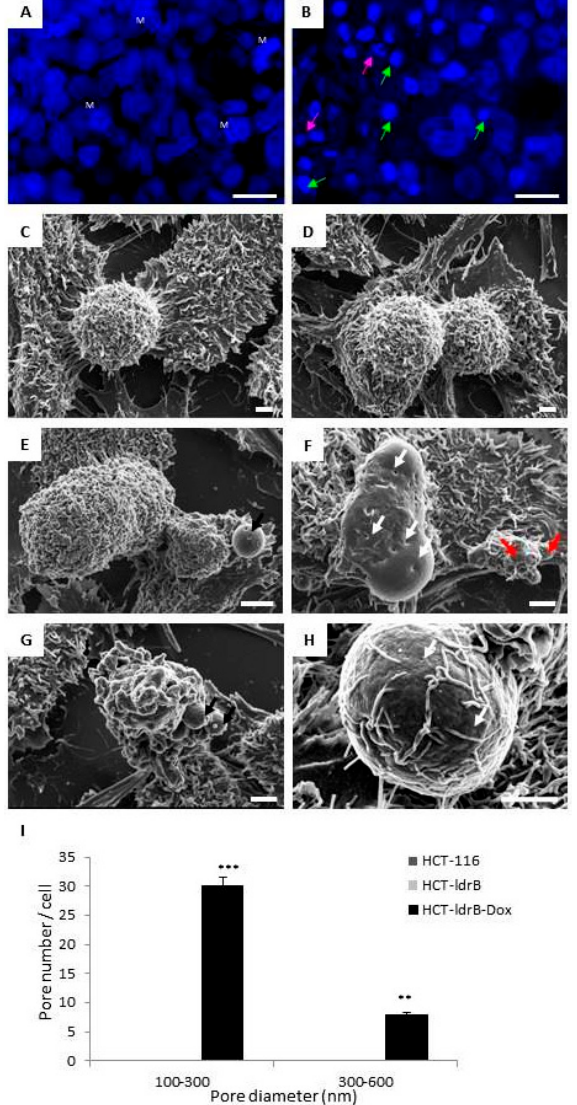
Figure 4. Expression of the ldrB gene induces apoptosis and pore formation in HCT-ldrB-dox cells. ( A ) Hoechst 33342 staining of HCT-116 cells showed a uniform nuclear stain and high levels of mitosis (M), while in HCT-ldrB-dox cell line ( B ), a large number of cells with nuclear fragmentation (purple arrow), many with condensed chromatin (green arrow), was observed (scale bar = 20 µm). Scanning electron microscopic images of HCT-116 ( C ) and HCT-ldrB ( D ) control cells were rounded and adhered to the culture surface with multiple filipodia. HCT-ldrB-Dox cell line showed cells of different sizes with signs of apoptosis with cytoplasmic membrane disruption, many apoptotic bodies, and clear signs of substrate detachment ( E – G ). Most of the cells had pores on their membrane surface ( E,F,H ). White arrows signal apoptotic bodies, and black arrows signal pores (scale bar = 2 µm). (I) Quantification of pore number. The height of each bar represents the number of pores with diameters in the interval between its lower and upper bounds on the x -axis. Pore diameters between 100–600 nm could be observed only in HCT-ldrB-Dox cells. Quantifications were measured from the SEM images (8 random photos) from three independent sample preparations. The data are represented as mean ± SD (** p < 0.01 vs. control and *** p < 0.001 vs.